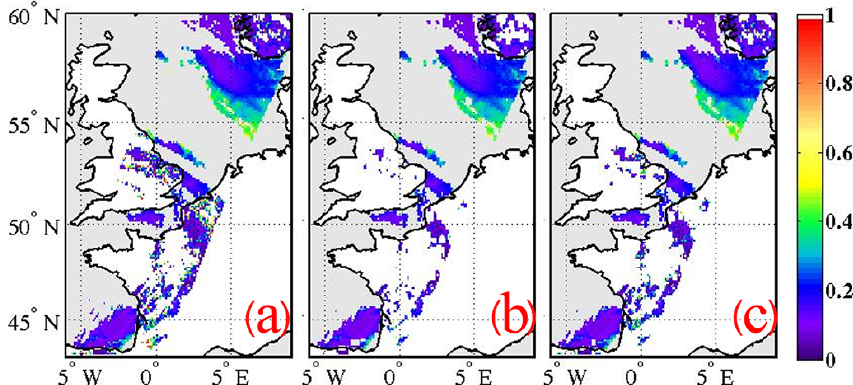
Figure 3. Example of a retrieval scene over western Europe, for the overpass on 29 July 2008, ca. 10:00UTC (as in Fig. 1): all L2 AOD pixels retrieved (a) , after the application of the initial cloud post-processing method discussed in Sect. 3.1 (b) and after the application of the improved post-processing discussed in Sect. 3.2 (c)